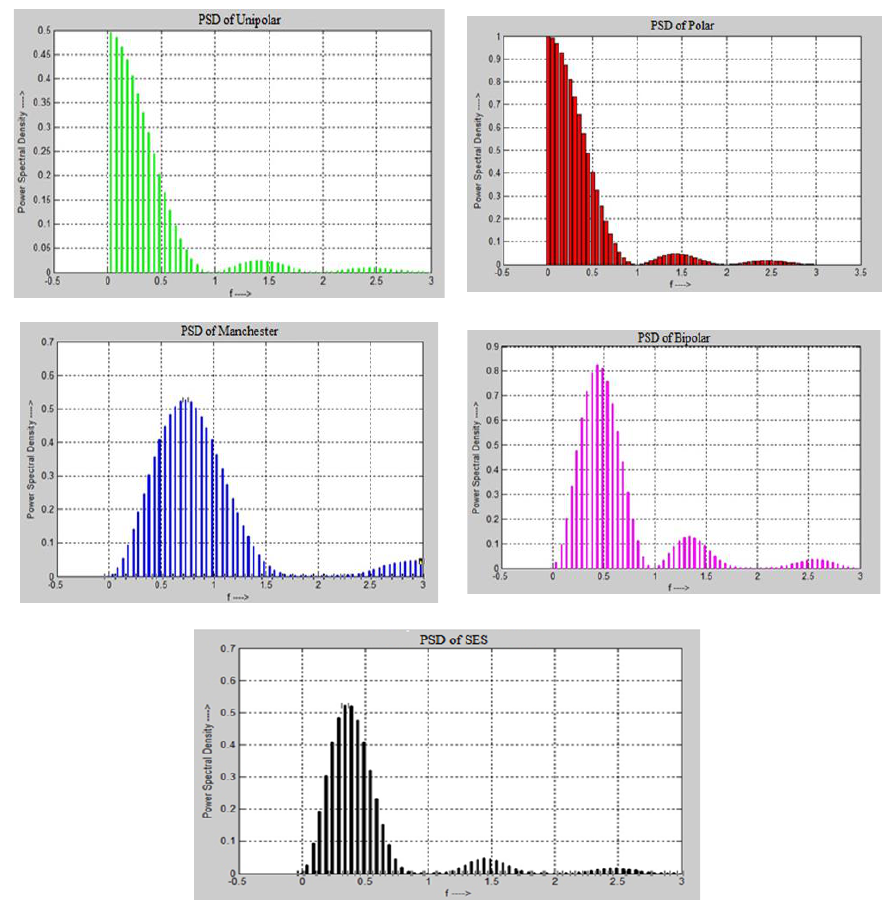
Figure 9. PSD calculation of SES with other digitizing schemes.